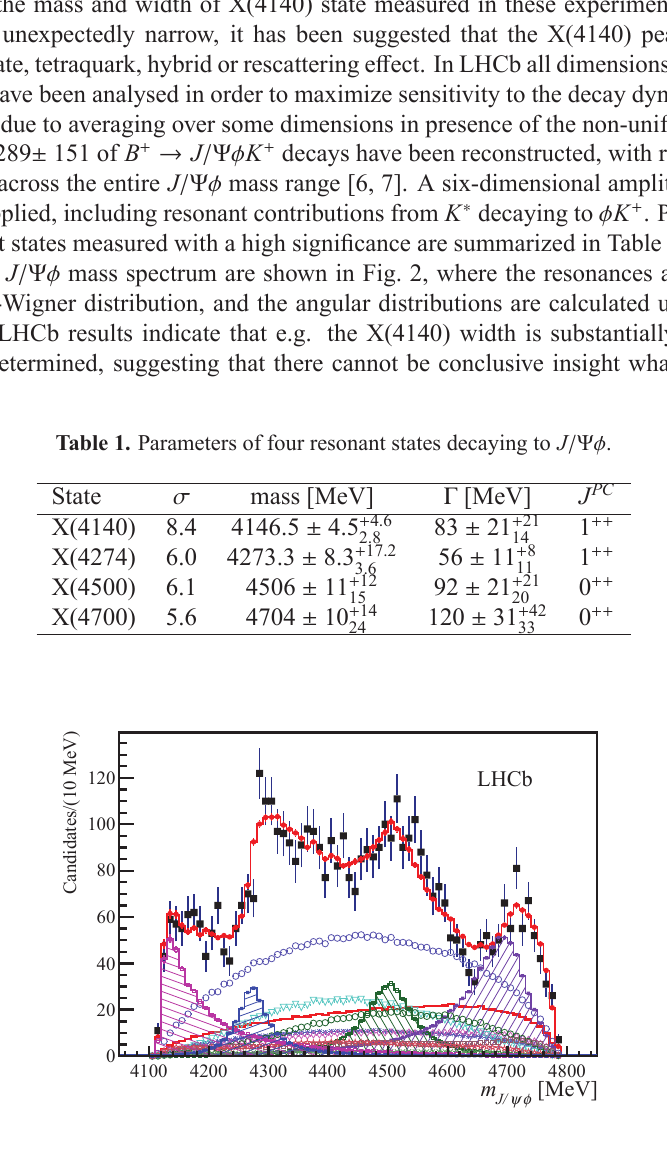
Figure 2. Distributions of the φ K + (top left), J / Ψ K + (top right) and J / Ψ φ (bottom right) invariant masses for the B + → J / Ψ φ K + coandidates from data (black points), compared to the results of the default amplitude fi t containing eight K ∗ + → φ K + and X → J / Ψ φ contributions. The total fi t is given by the red points with error bars, and individual fi t components are also shown. Figure adopted from